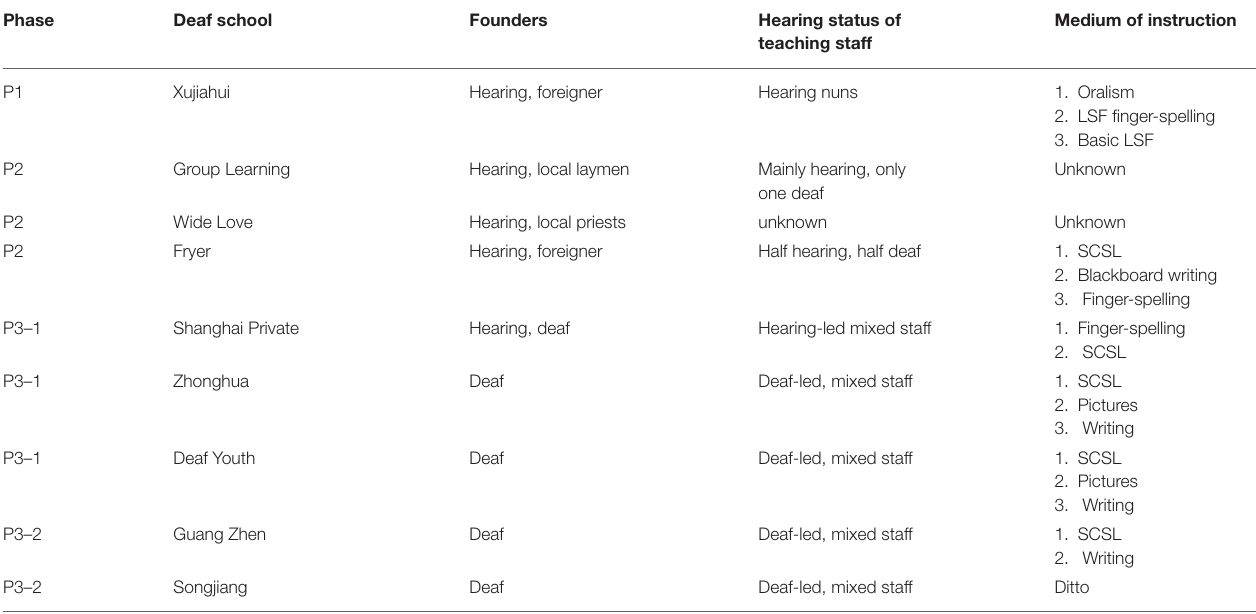
TABLE 4 | Founders, staff, and medium of instruction in Shanghai deaf schools in different phases.